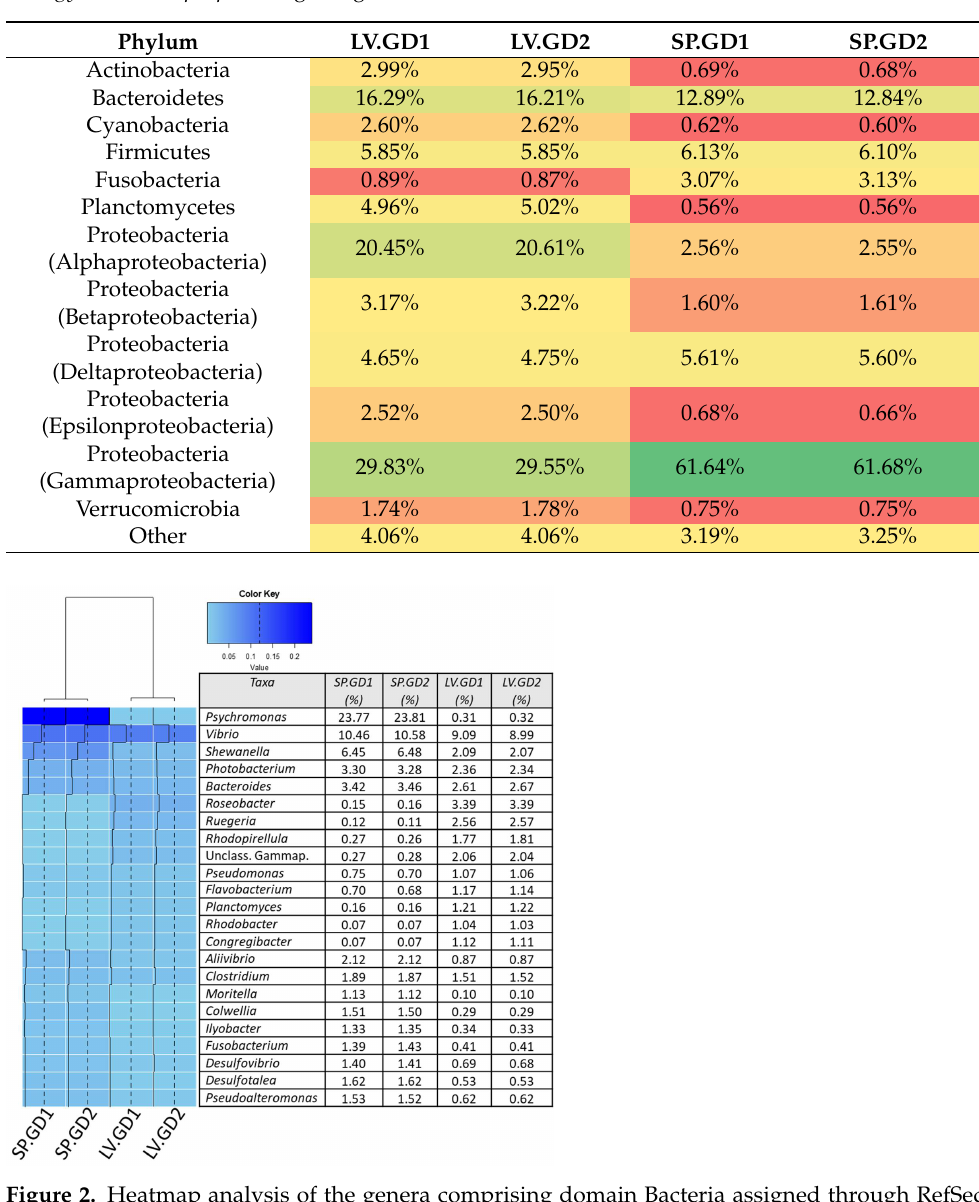
Figure 2. Heatmap analysis of the genera comprising domain Bacteria assigned through RefSeq using MG-RAST (v4.0.3). The analysis was performed using R (v3.3.2) with the heatmap.2 function from the gplots (v3.0.1) package. The sample dendrogram was constructed based on the Bray–Curtis similarity value through Vegan (v2.4.3), and the gradient of relative abundance was illustrated us- ing RColorBrewer package as “blue” for more abundant and “sky blue” for less abundant. The trace lines (black) were generated to further elaborate on the relative abundance of taxa. Samples are indicated as follows: LV.GD = green sea urchin Lytechinus variegatus gut digesta; SP.GD = purple sea urchin Strongylocentrotus purpuratus gut digesta.